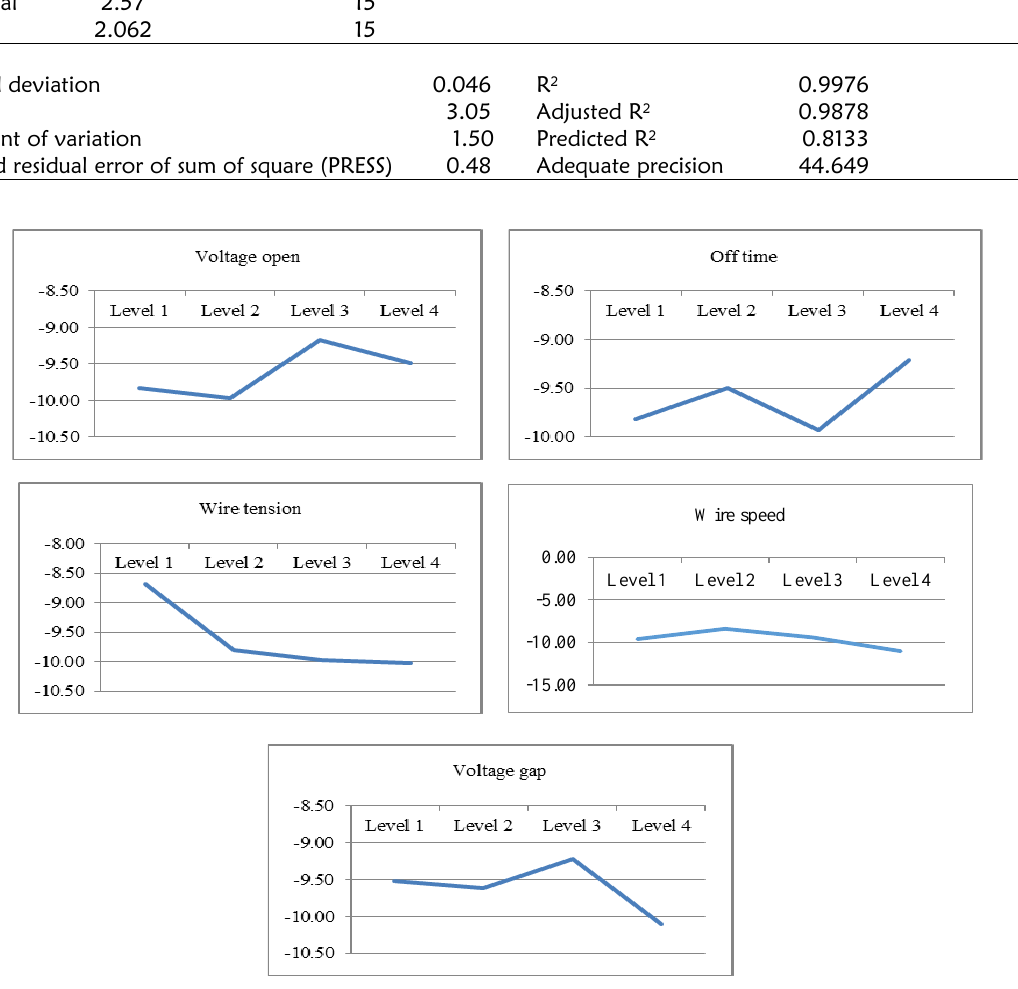
Figure 1: Effects of process parameters on mean S/N ratio for R